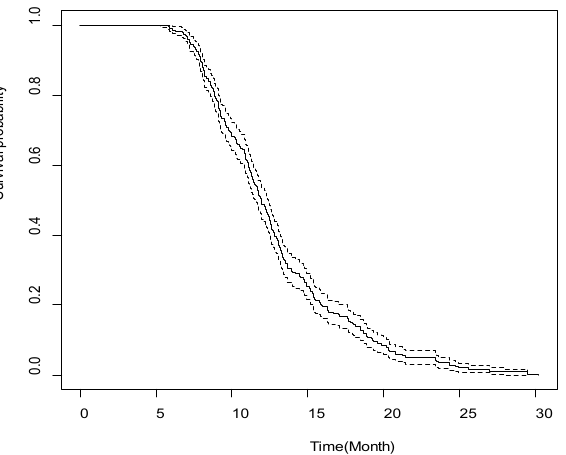
The marginal survival plot is shown in Figure 2. As a result of the marginal survival analysis, no statistically significant variables were observed.